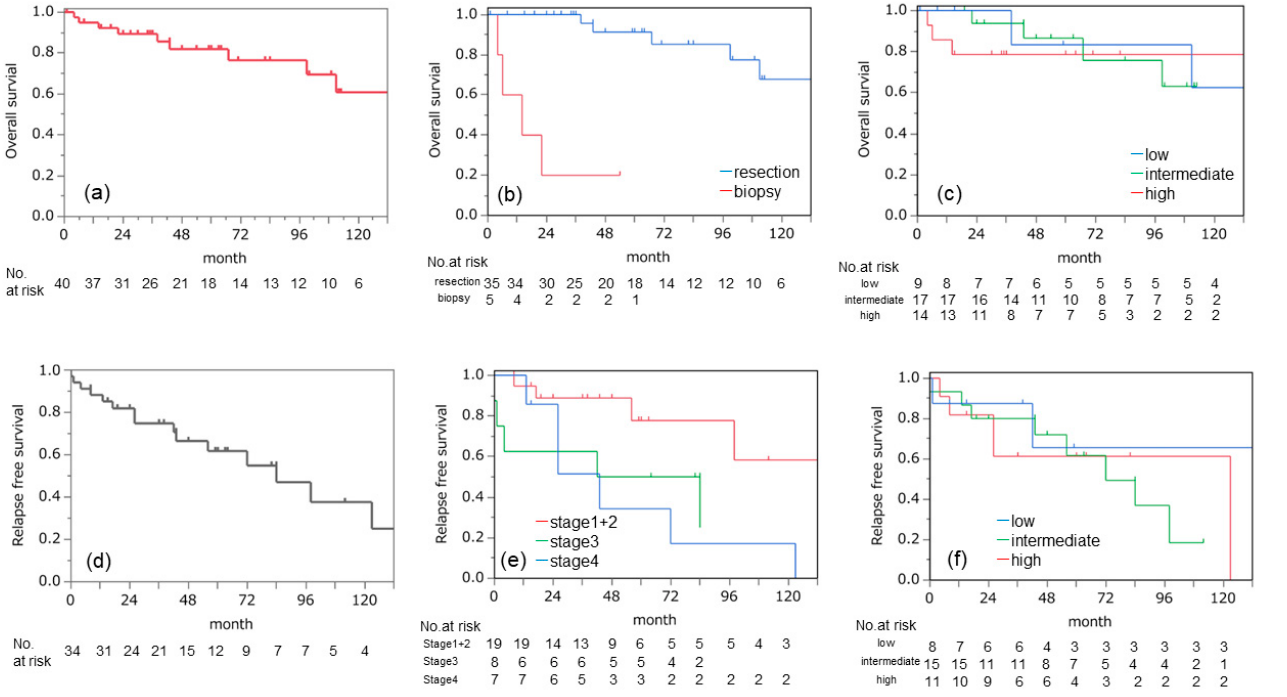
Figure 1. ( a – f ) Kaplan-Meier curves with patients according to ( a ) overall survival of all cases; ( b ) overall survival for resection or biopsy groups; ( c ) overall survival for histopathological type; ( d ) relapse-free survival of all cases; ( e ) relapse-free survival for pathological TNM stage; and ( f ) relapse-free survival for histopathological type. Table 3. Univariate analysis of overall